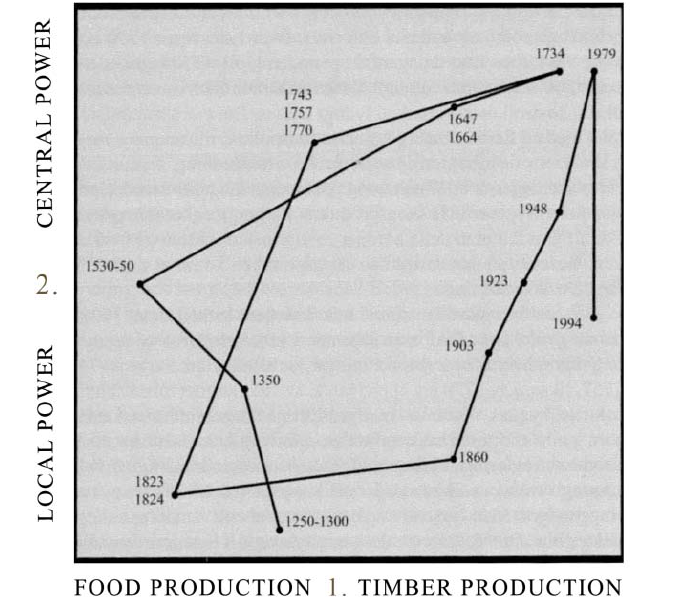
Figure 1. A history of competing land use between wood and food production, expressed by the changes in Swedish forestry policies since the year 1250. Laws on the left of the field promoted food production. Laws on the right promoted wood production. Vertically one can see how the legislation is related to the question of who had the power to control the use of land. Laws at the top promoted a strong governmental power while laws in the lower part stressed self-determination or decentralization. Adapted from